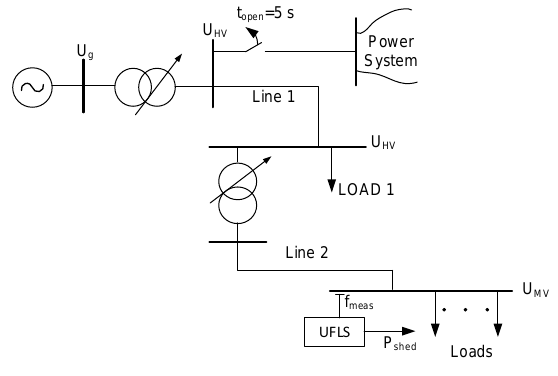
Figure 4. Test system topology.